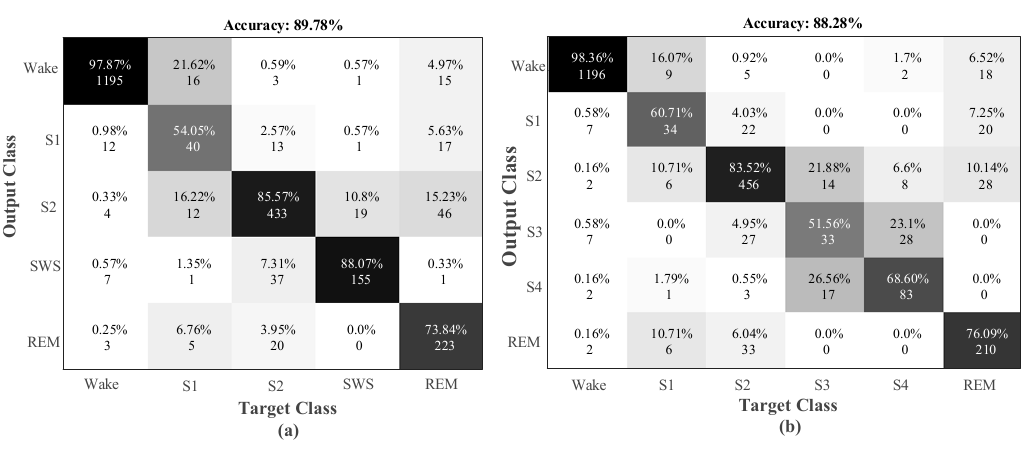
Figure 5. Confusion matrix obtained using single-channel EOG input signals for the sleep-edf data for: ( a ) five-class test data and ( b ) six-class test data.